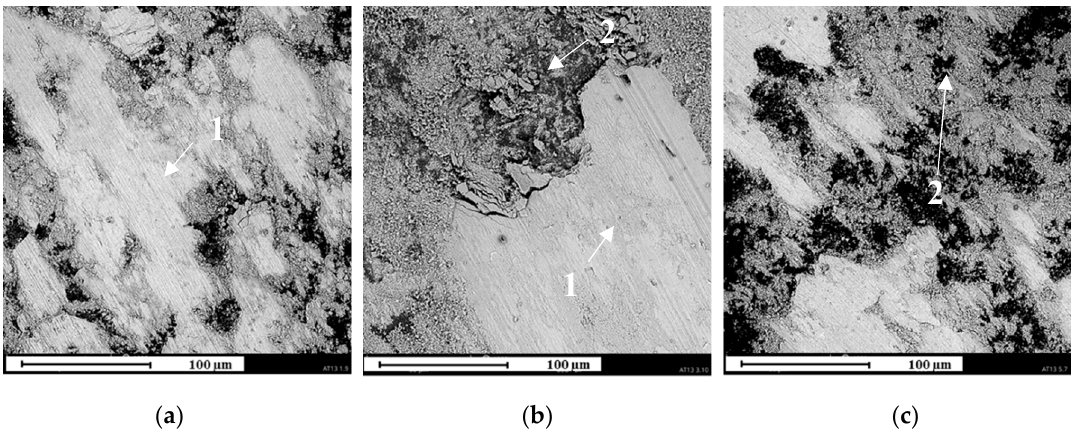
Figure 13. The wear track surface of: ( a ) AT13-1 (L = 80 mm; V = 300 mm/s), ( b ) AT13-3 (L = 90 mm; V = 400 mm/s), and ( c ) AT13-5 coating (L = 100 mm; V = 500 mm/s): 1 — smooth wear track, 2 — rough debris.